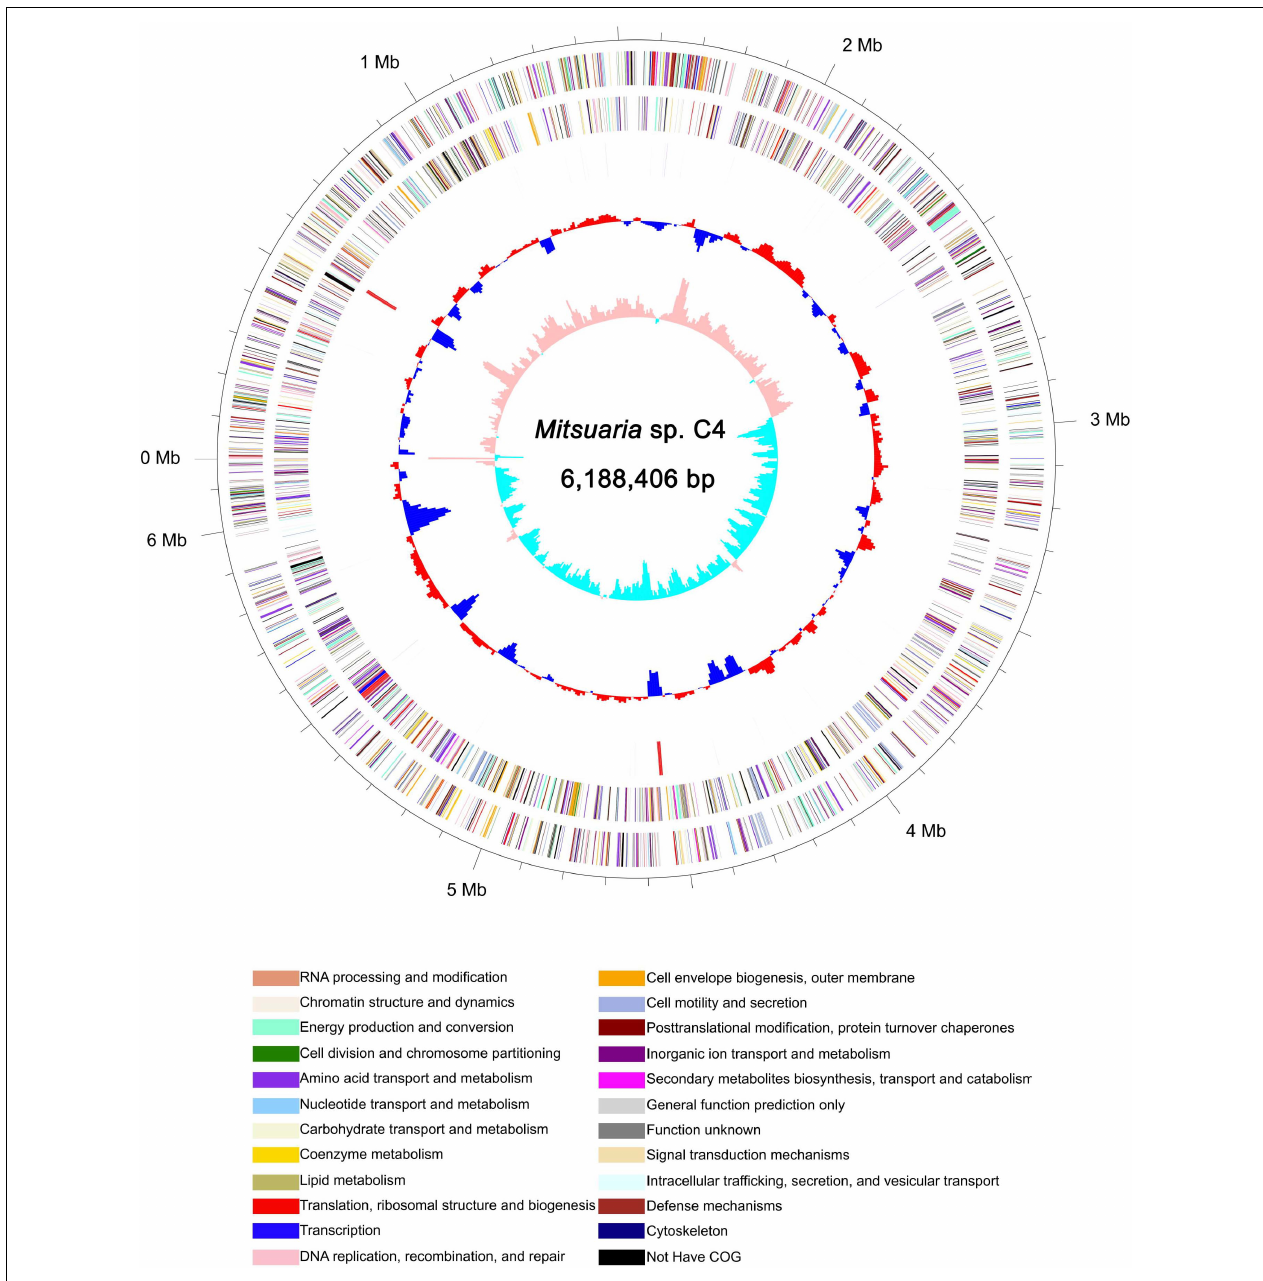
FIGURE 5 | Schematic of complete Mitsuaria sp. C4 genome. Order of circles from outermost to innermost is as follows: genome size (first circle), CDS on forward and reverse strands (second and third circles), COG categories, rRNA and tRNA (fourth circle); GC content (fifth circle), and GC skew (sixth